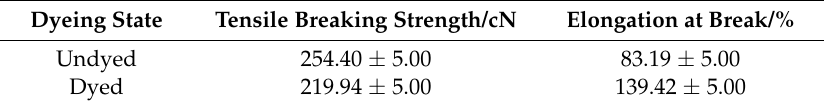
Table 5. Mechanical properties of warp-knitted fabrics.